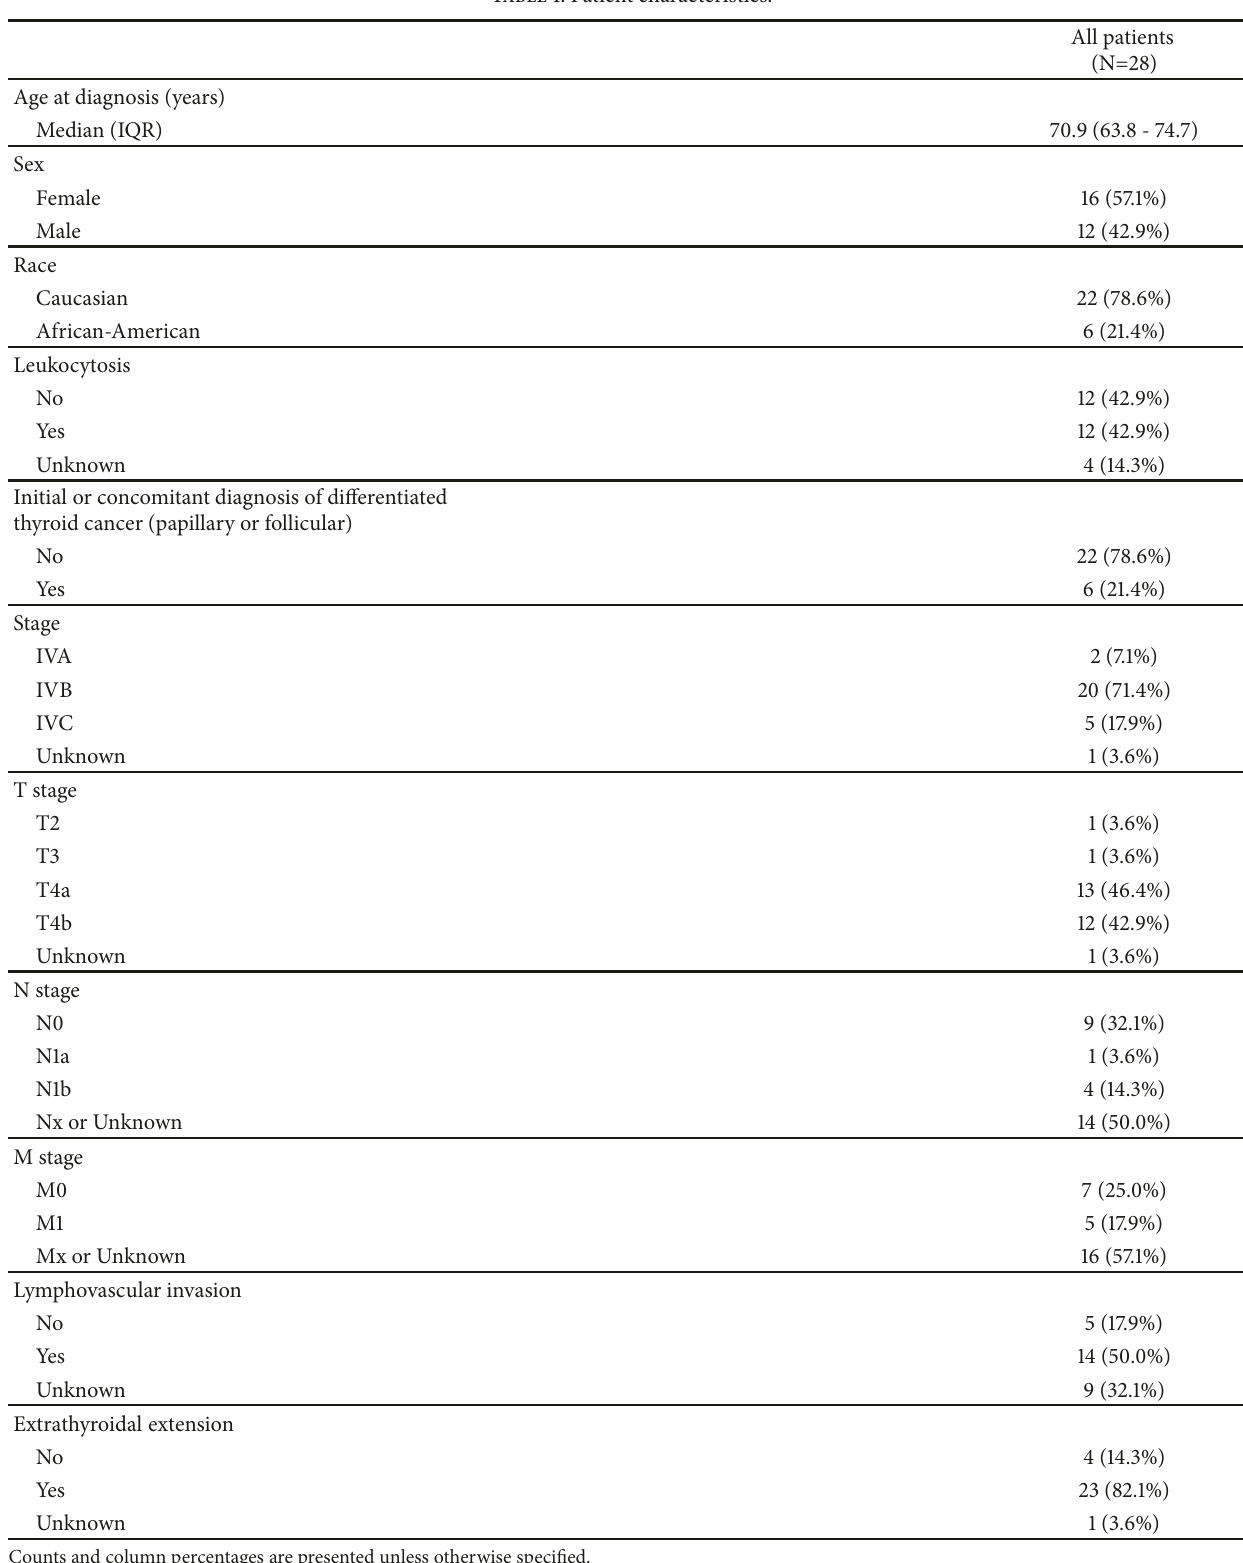
Table 1: Patient